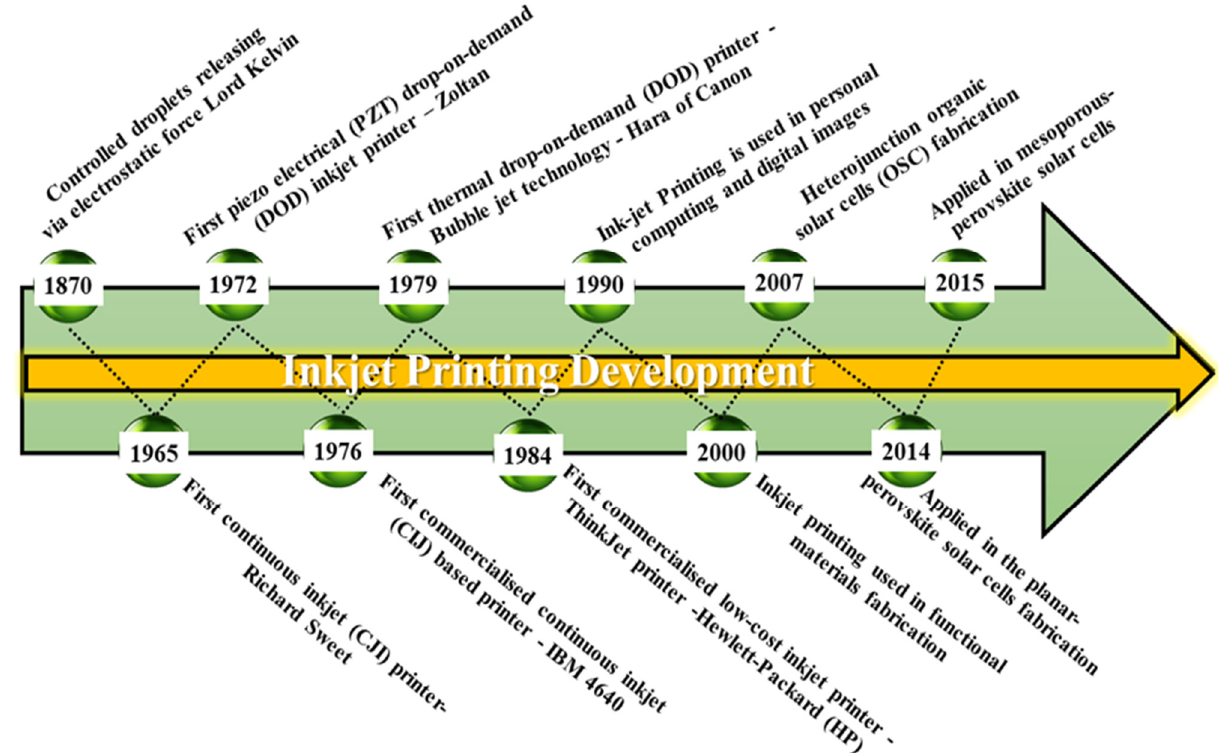
Figure 6. Progression of inkjet printing development.